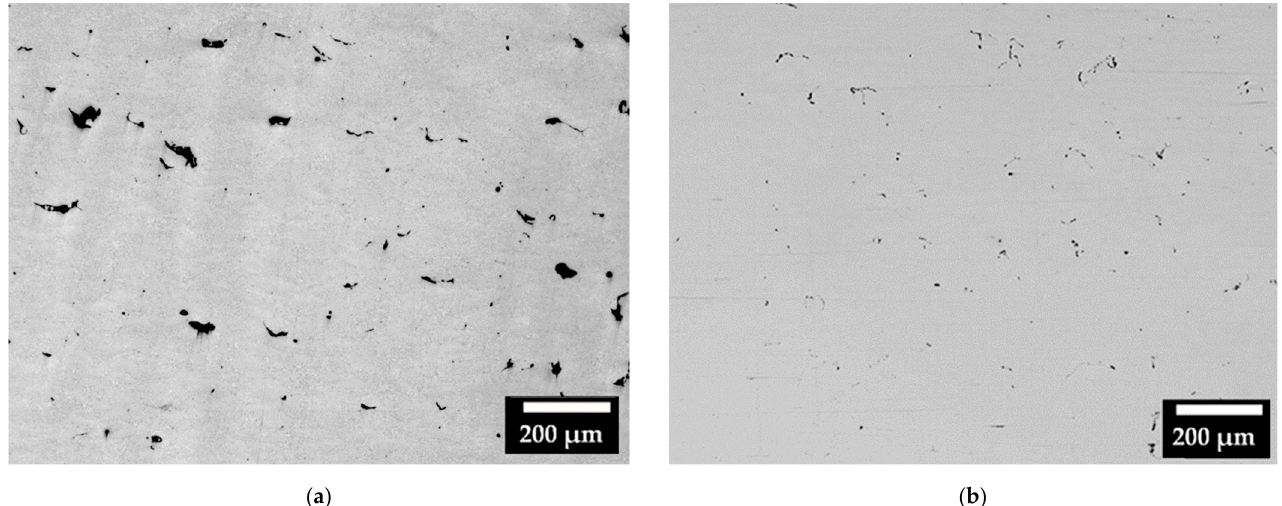
Figure 4. Micrographs of ( a ) CL31 and ( b ) HM, XZ cross ‐ sections.